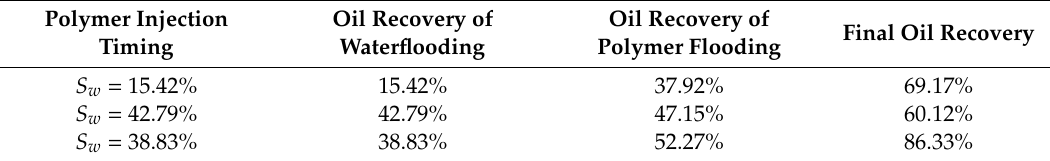
Figure 7. Microscopic oil displacement at different polymer injection timing (Upper: S w = 15.42%; Middle: S w = 42.79%; Lower: S w = 38.83%). ( a ) Initial state; ( b ) after waterflooding; ( c ) after polymer flooding; ( d ) after post-waterflooding. Table 3. Comparison of recovery rates.